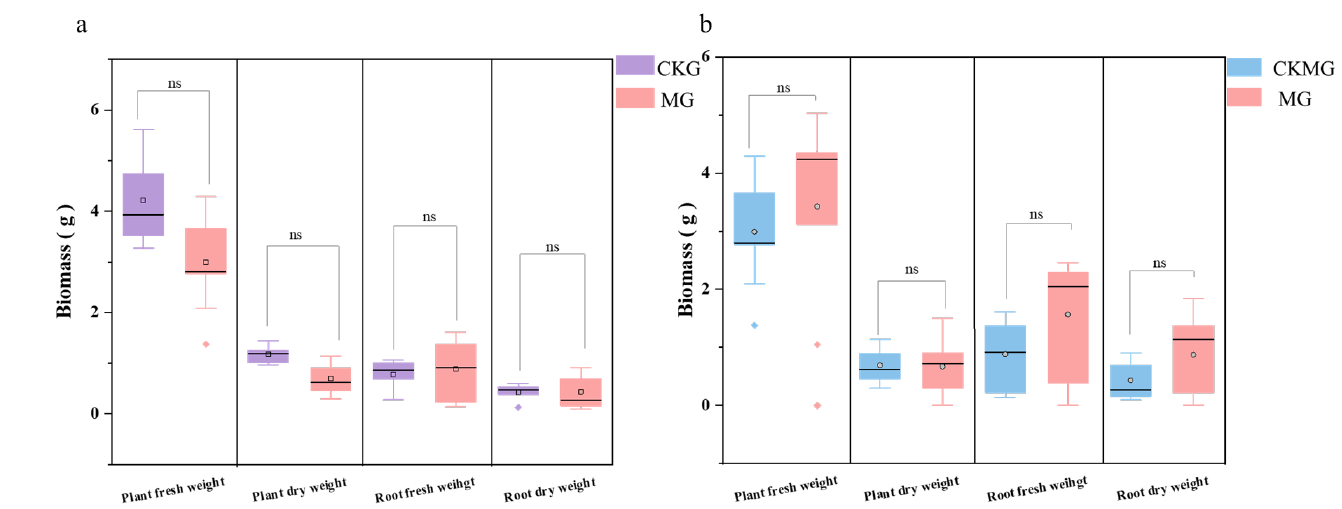
Figure 1. Comparison of forage biomass under different planting patterns. ( a ) Comparison of unfertilized monoculture grass biomass and organic fertilized mixed sowing grass; ( b ) Comparison of grass biomass in mixed sowing with and without organic fertilizer; ns means that there is no significant difference between the groups. CKG represents the grass that did not apply organic fertilizer in monoculture; MG represents the grass with mixed sowing and fertilization. CKMG represents the grass which was mixed without organic fertilizer.